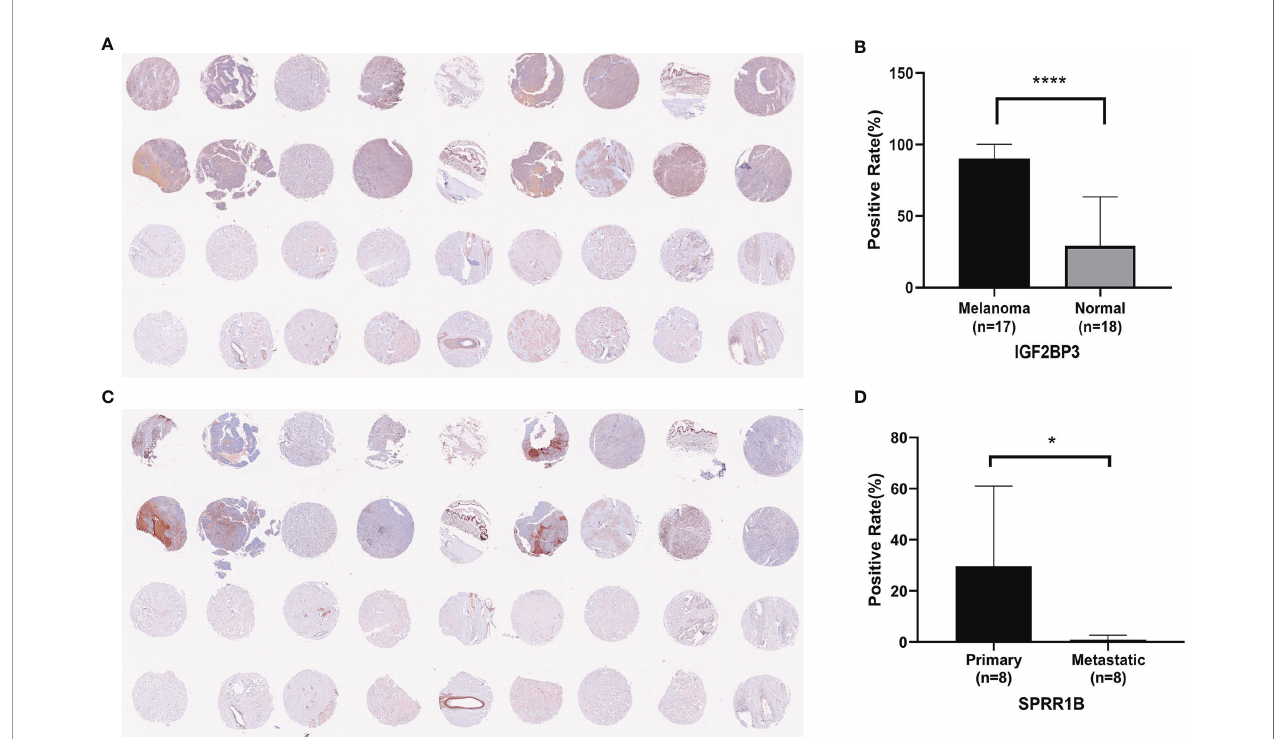
FIGURE 11 | (A) Immunoreactivity of IGF2BP3 in human melanoma and normal skin tissue; (B) Positive rate of IGF2BP3 in human melanoma and normal skin tissue, where *P < 0.05; (C) Immunoreactivity of SPRR1B in human melanoma and normal skin.; (D) Positive rate of SPRR1B in primary melanoma and metastatic melanoma, where ****P <